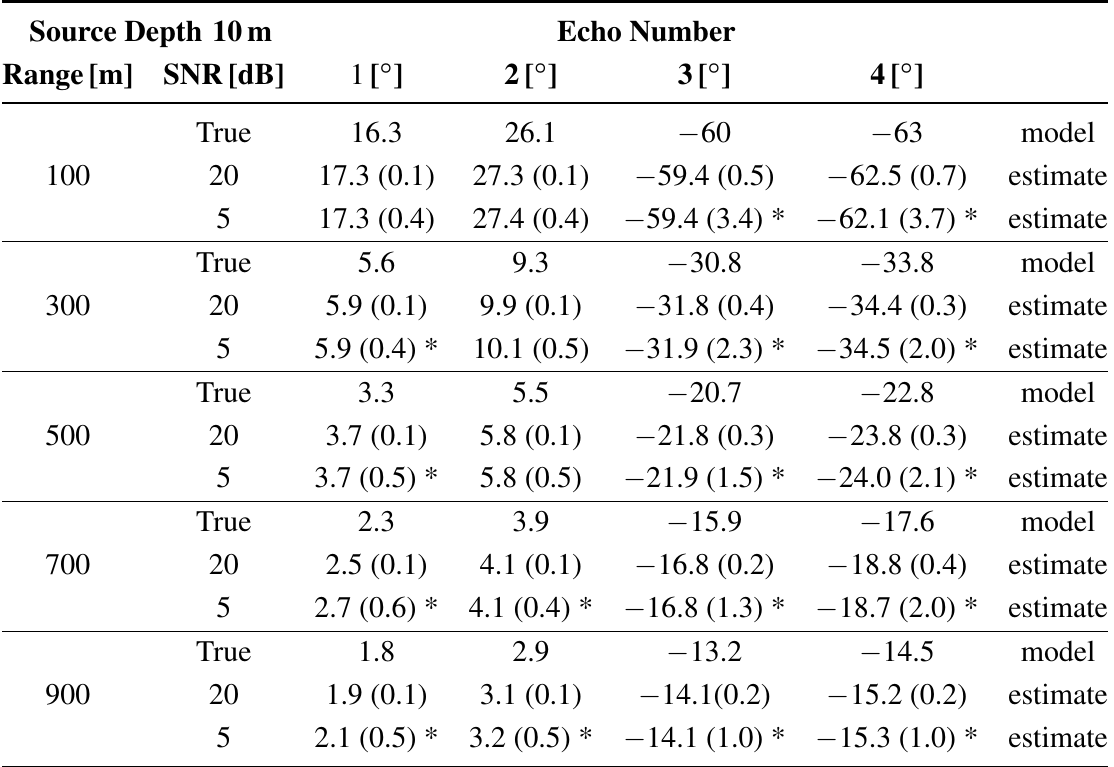
Table 1. Estimated angles of the four earliest echoes impinging on the vector sensor at different source distances as given by the forward model (true) and estimated considering an signal to noise ratios (SNR) of 20 and 5 dB. The values in curved brackets represent the standard deviations. The star mark indicates that at least one sign error occurred in the ensemble of estimates for the given